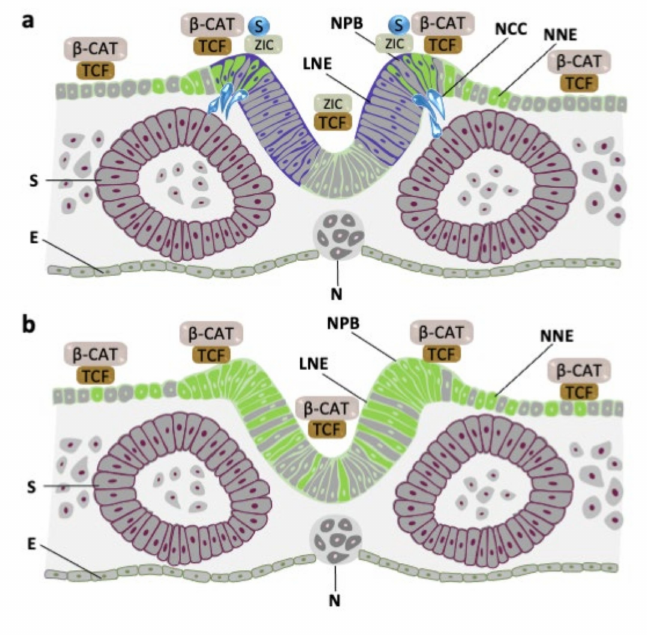
Figure 7. SUMOylation of ZIC proteins can influence NCC specification. A diagram explaining how ZIC protein activity at the neural plate border can restrict the region of NCC specification. ( a ) During normal development, WNT signaling sufficient to cause TCF activation of gene expression is restricted to the neural plate border and some non-neural ectoderm cells. Zic gene expression is within the lateral neurectoderm and neural plate border. In the lateral neurectoderm, basal ZIC acts as a TCF co-repressor. At the neural plate border, high-WNT activity promotes ZIC SUMOylation and transcription factor activity at ZREs, including those that drive expression of the Foxd3 specifier gene. ( b ) When Zic gene expression is depleted in the lateral neurectoderm, TCF activation of gene expression expands throughout the neurectoderm and into the non-neural ectoderm. Simultaneously, the lack of ZIC protein prevents activation of Foxd3 expression. E: endoderm, LNE: lateral neurecto- derm, NCC: neural crest cells, NPB: neural plate border, NNE: non-neural ectoderm, N: notochord, S: